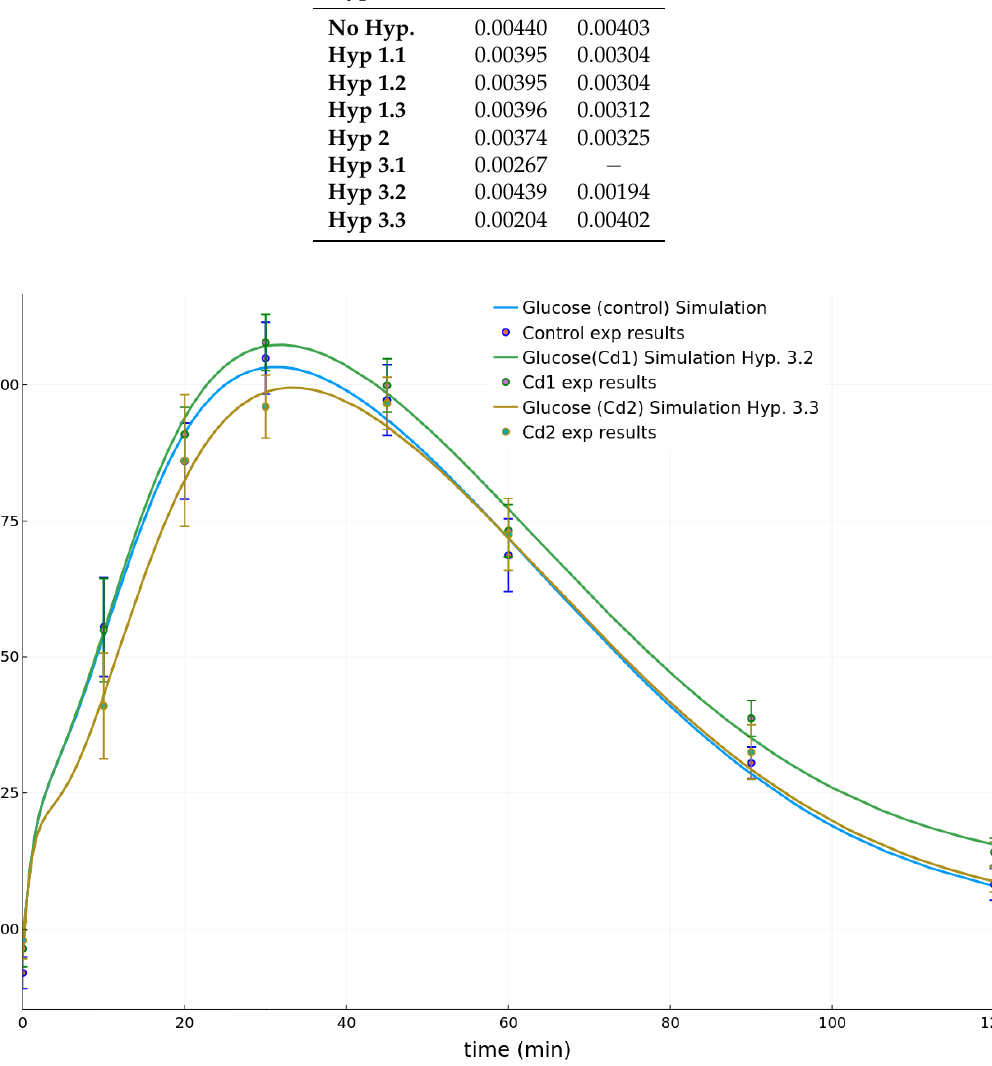
Figure 6. Simulations of the OGTT at PND60 for the control group and groups Cd1 and